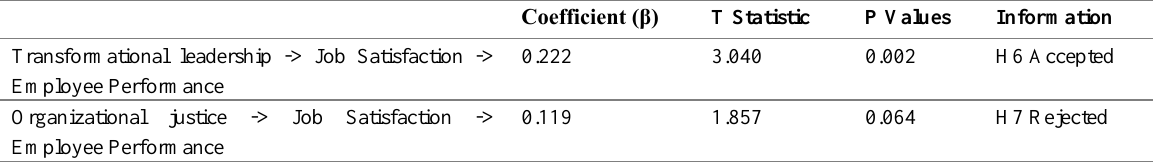
Table 6: Result of Indirect Effect